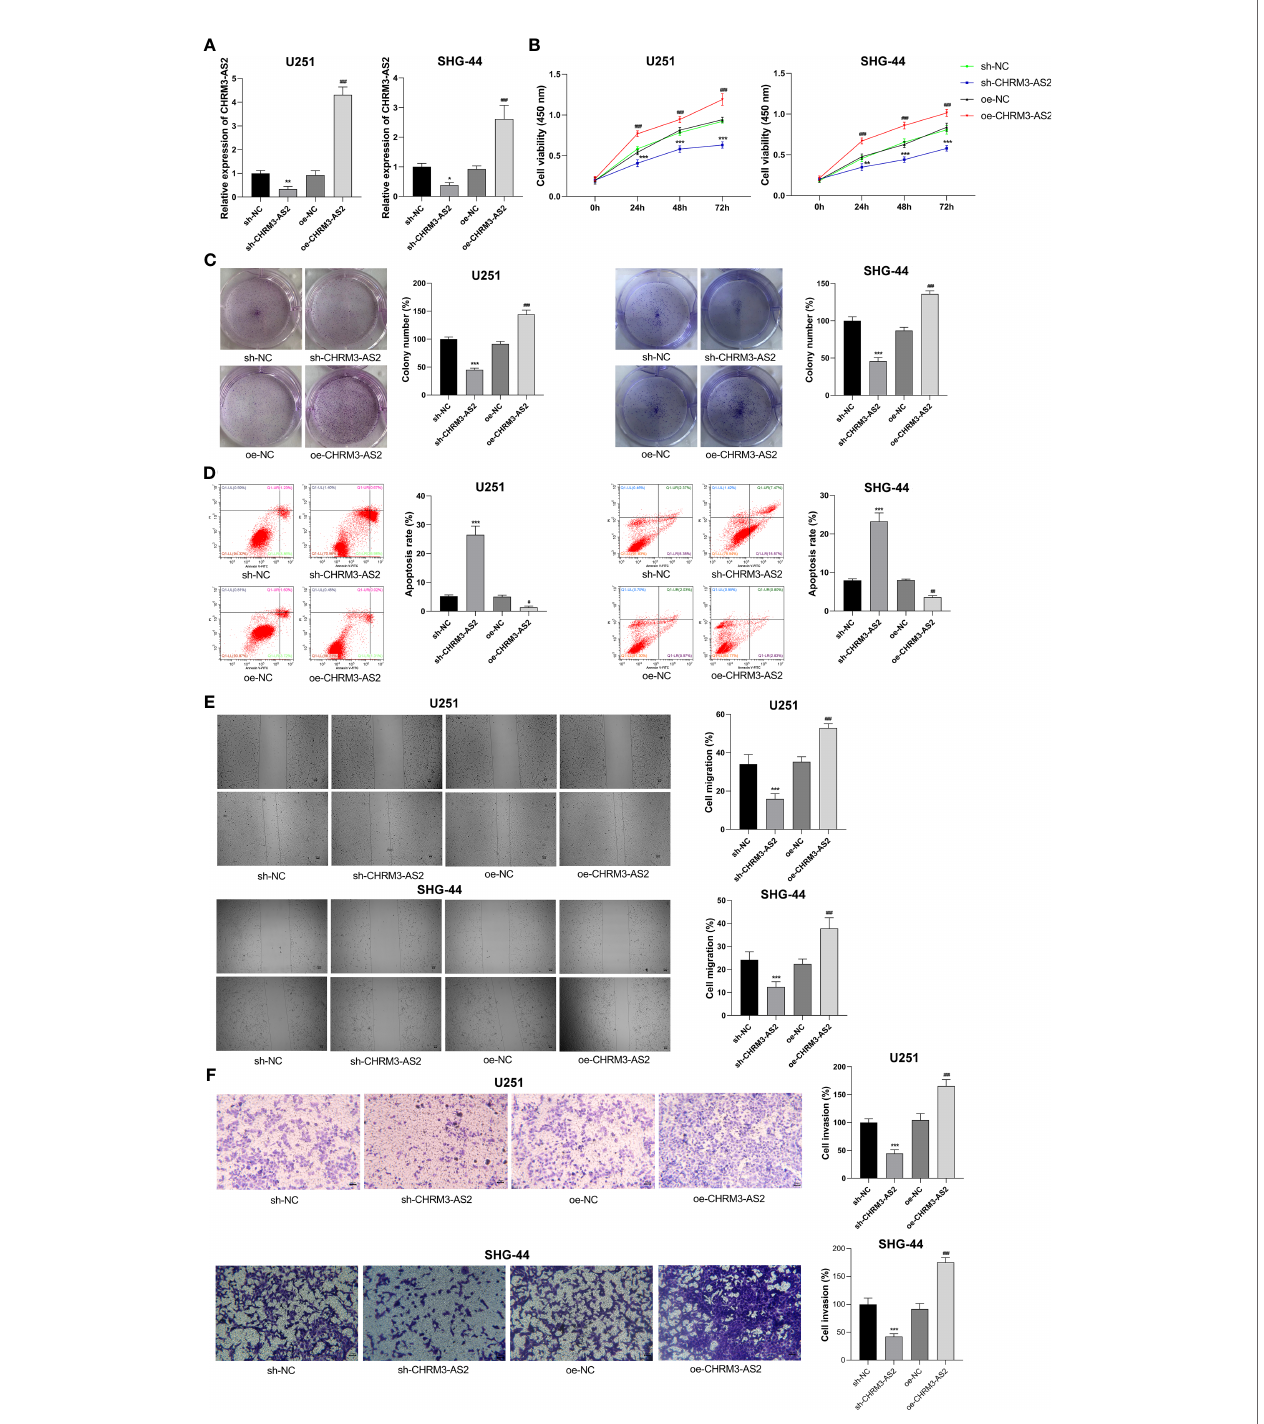
FIGURE 3 | CHRM3-AS2 inhibited the malignant characteristics of glioma cells. (A) Expression of CHRM3-AS2 was quanti fi ed via qRT-PCR. (B) Cell viability was measured using CCK-8 assays. (C) Colony numbers were measured using colony formation assays. (D) Cell apoptosis was evaluated via fl ow cytometry. (E) Cell migration was evaluated using wound healing assays. (F) Cell invasion was analysed using Transwell assays. U251 and SHG-44 cells were transfected with sh- CHRM3-AS2/sh-NC or oe-CHRM3-AS2/oe-NC. *P < 0.05, ** P < 0.01, ***P < 0.001 vs. sh-NC; ## P < 0.01, ### P < 0.001 vs.